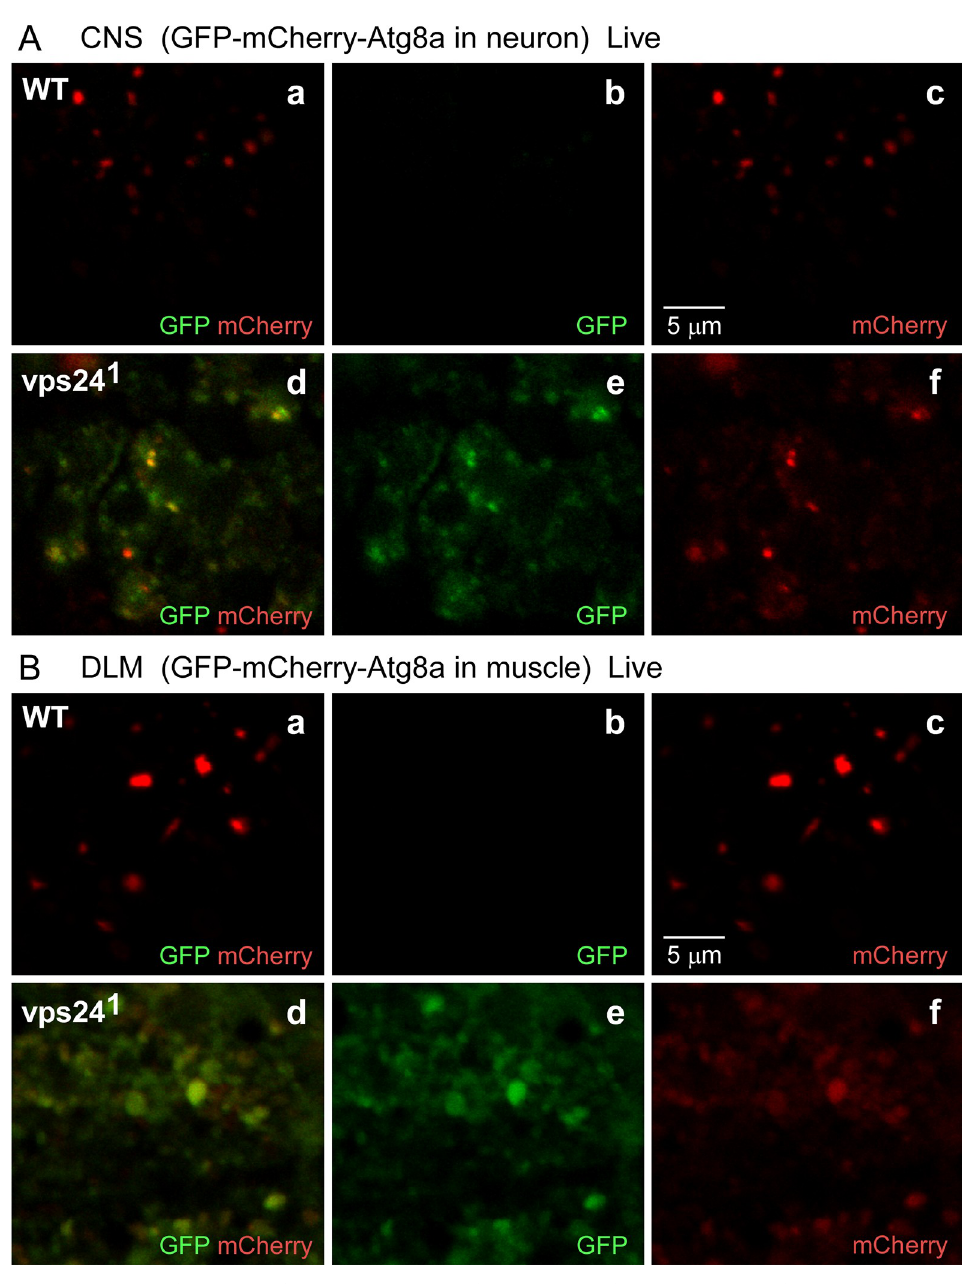
Fig 9. The GFP-mCherry-Atg8a fusion proteins accumulate in a non-acidic compartment in the vps24 mutant. Confocal live-imaging of the GFP-mCherry-Atg8a fusion protein in CNS neurons (A) and DLM (B) from WT (a-c) or the vps24 mutant (d-f) . Neuronal (A) or muscle (B) expression of the tandem-tagged fusion protein was achieved as described in Fig 2. In both neurons and muscle of the vps24 mutant, colocalized GFP and mCherry fluorescence was detected (Ad-f, Bd-f) . This indicates that the pH-sensitive GFP tag is not quenched and thus the tandem-tagged fusion protein is in a non-acidic compartment. In WT neurons and muscle (Aa-c, Ba-c) , the GFP fluorescence signal is diminished with respect to the mCherry